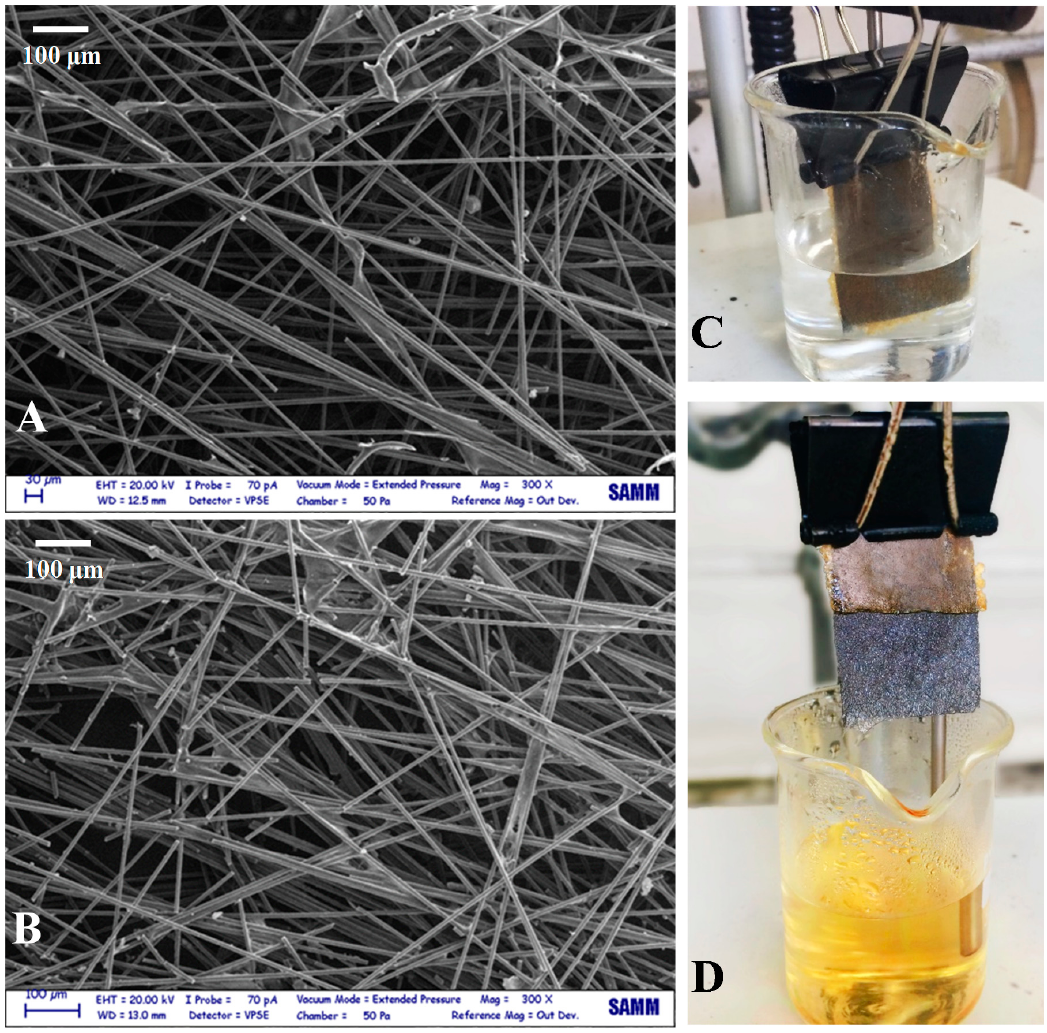
Figure 8. Solvolysis proof-of-concept: Composite sample partially immersed in solvent at room temperature ( A ) and removed after washing at 120 °C ( B ). SEM images of virgin nonwoven mat ( C ) compared to the one recovered from solvolysis in propylene carbonate ( D ).